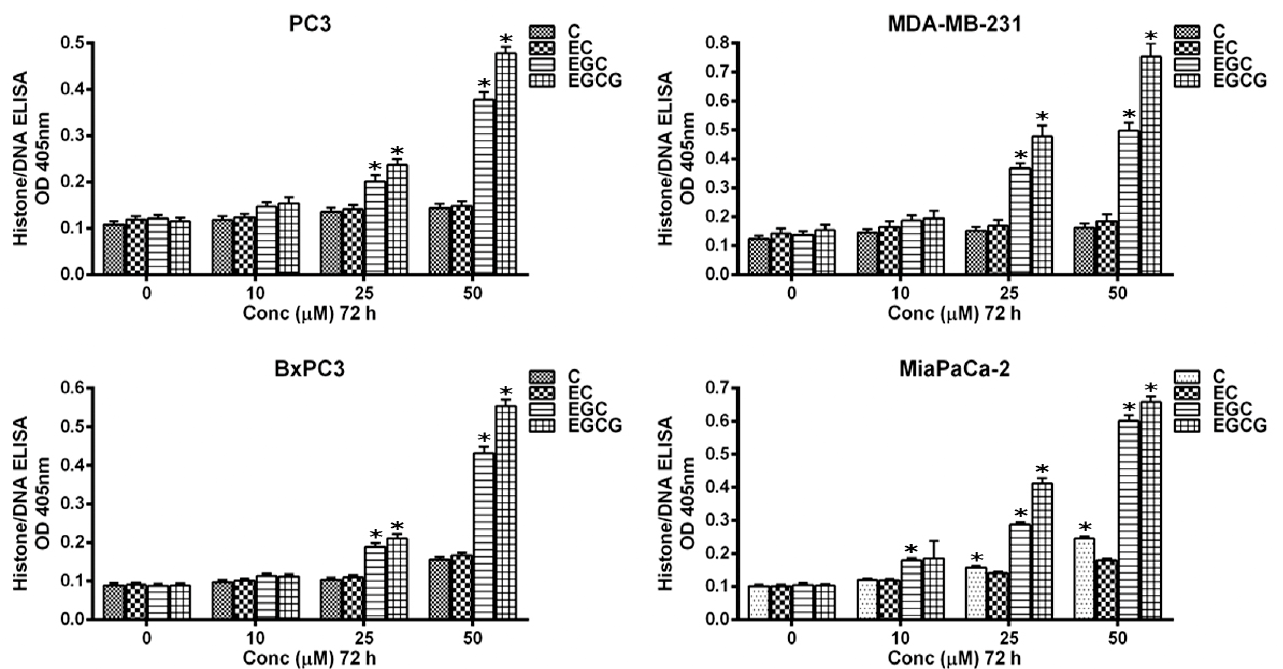
Figure 3. Apoptosis induction by C, EC, EGC, and EGCG in different cancer cell lines. The Cell Death Detection ELISA Kit (Roche, Palo Alto, CA, USA) was used to detect apoptosis in cells from different cancer cell lines after incubation for 72 h with increasing concentrations of C, EC, EGC, and EGCG as indicated in the figure and described in the Materials and Methods section. Values reported are ±S.E of three independent experiments. * p value < 0.01 when compared to control.